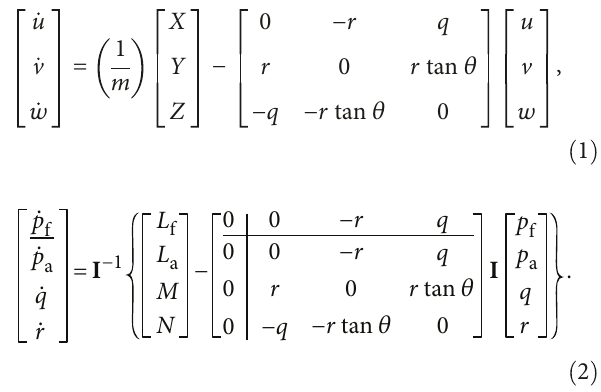
Figure 1: Structural diagram of dual-spinning projectile.